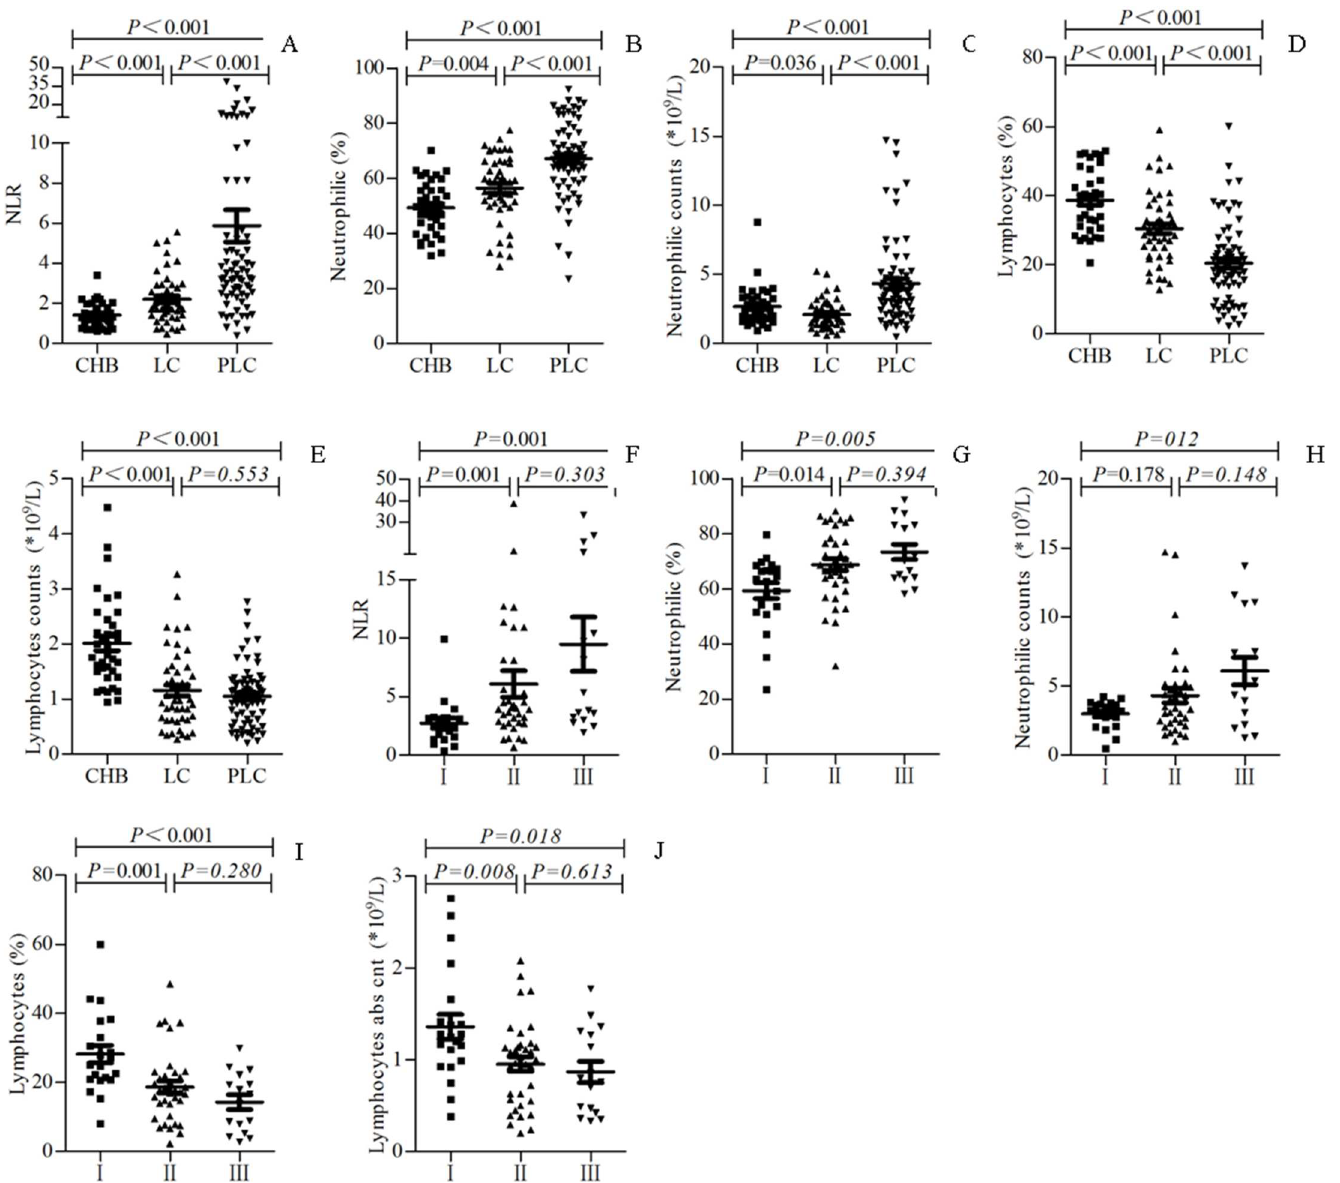
Fig 1. Elevated NLR in patients with HBV-PLC. NLR (A), percentage(B) and concentration (C) of peripheral blood neutrophils, and percentage (D) and concentration (E) of peripheralblood lymphocytes were comparedbetweenpatients with CHB, those with HBV-LC and those with HBV-PLC. In addition, NLR (F), percentage (G) and concentration (H) of peripheral neutrophils, and percentage(I) and concentration (J) of peripheral lymphocytes were comparedbetweenpatients with Okuda I, II and III HBV-LC. p < 0.05was considered statisticallysignificant.abs cnt: absolute